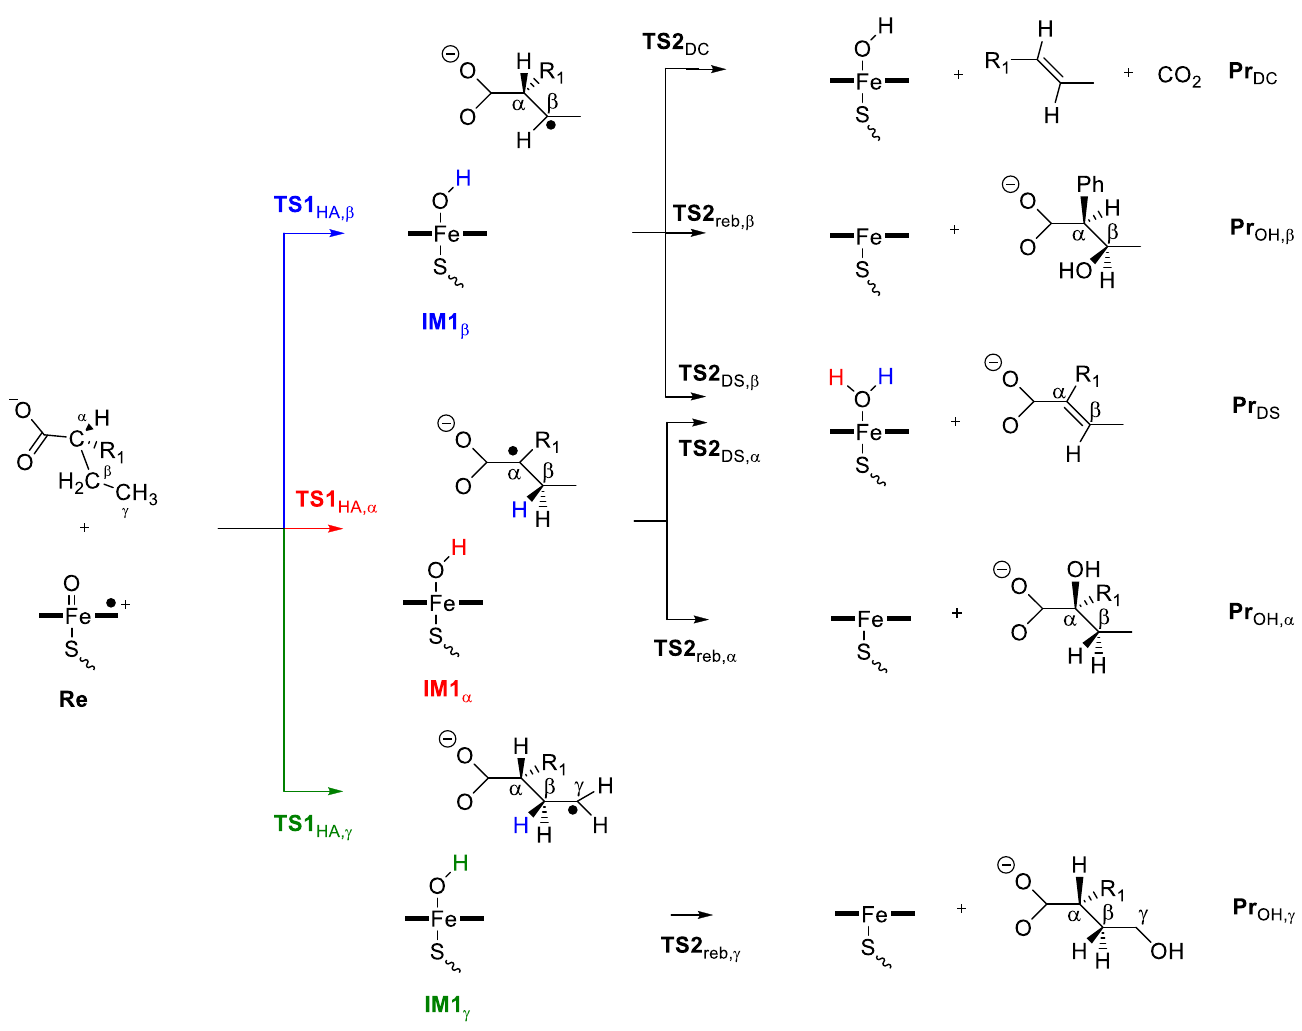
Scheme 3. Reaction mechanisms explored for substrate activation by P450 OleT JE with definition of the labels for the intermediates, products and transition states.